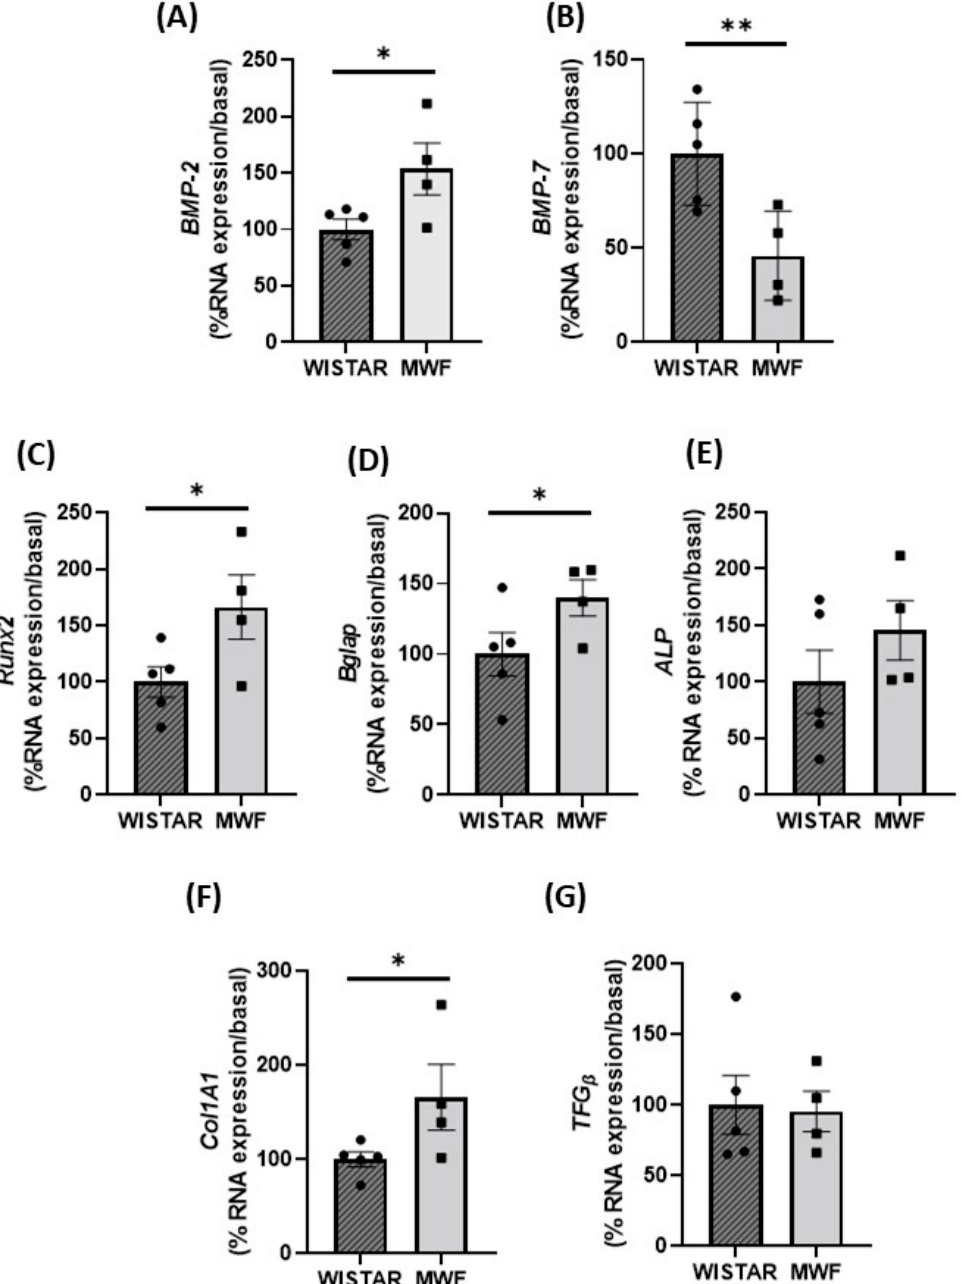
Figure 6. Expression of profibrotic and calcification makers in periaortic adipose tissue (PAT) of Wistar and MWF. mRNA expression level ( A ) BMP-2 , ( B ) BMP-7 , ( C ) Runx2 , ( D ) Bglap , ( E ) alkaline phosphatase ( ALP) , ( F ) Collagen 1A1 ( Col1A1) and, ( G ) TFG β mRNA expression level. Data are expressed as the mean ± SEM of n = 5 animals per group. * p < 0.05, and ** p < 0.01 compared to Wistar.